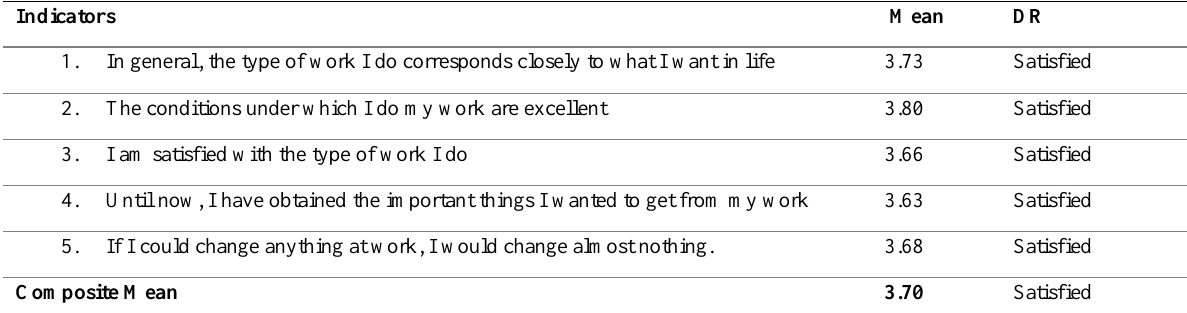
Table 3: Job satisfaction of the employees of Divine Word College of Laoag (n=